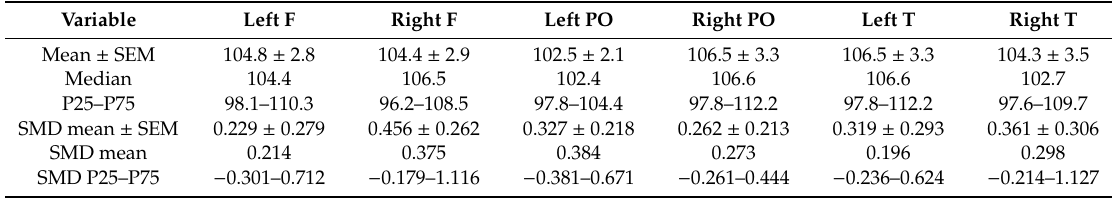
Table A5. Changes in spectral entropy during